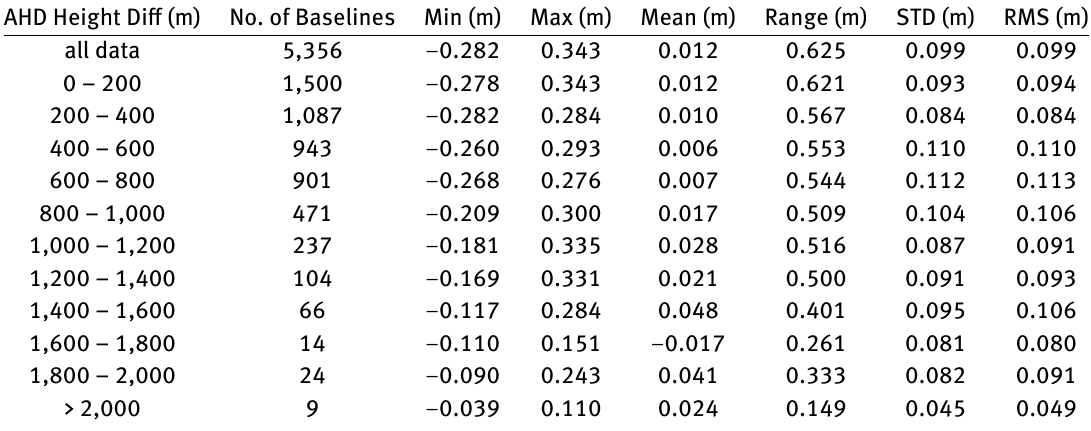
Table 3: Snowy Mountains verification: Descriptive statistics of the residuals between AUSGeoid09-derived and oflcial AHD height differ- ences as a function of AHD height